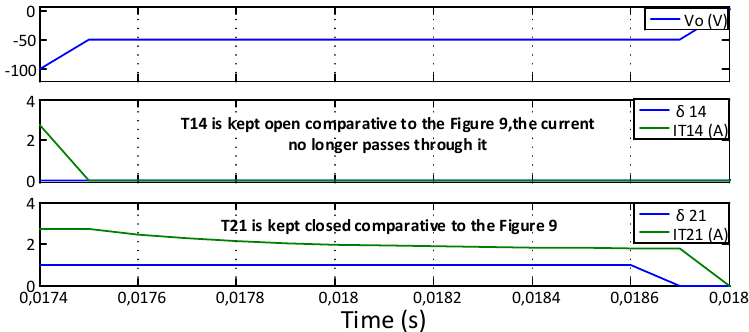
Figure 17. Voltage V o , currents IT21 and IT14, and switching patterns δ 21 and δ 14 (Zoom 3).